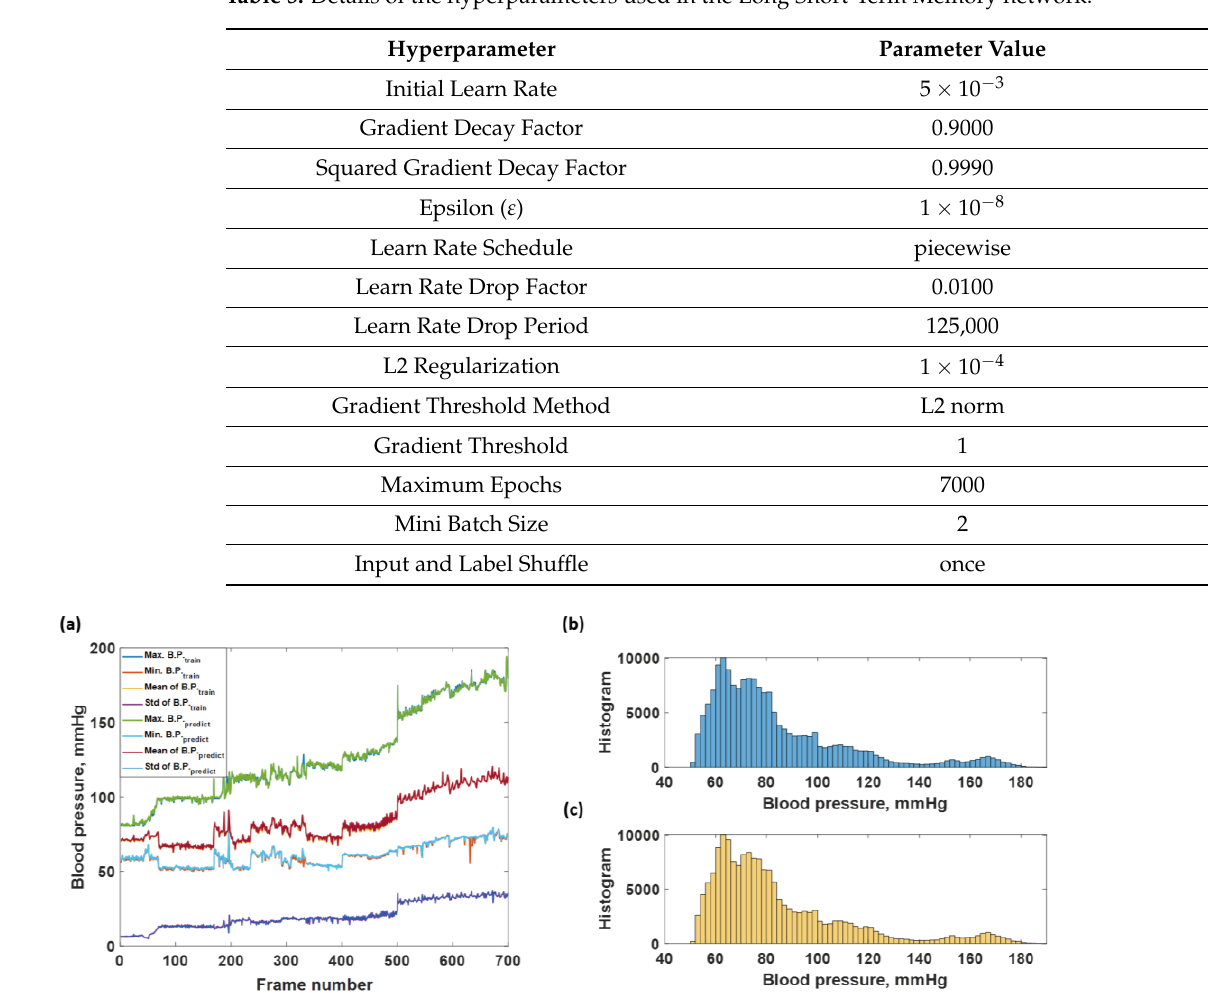
Table 5. Details of the hyperparameters used in the Long Short-Term Memory